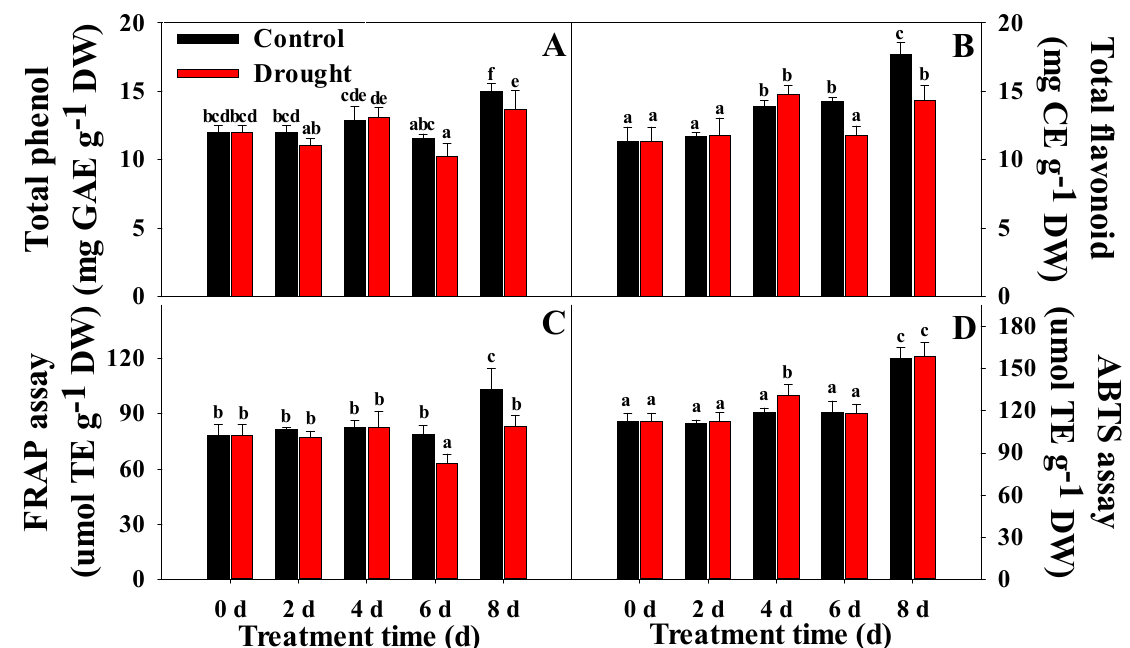
Figure 5. Effect of drought stress on total phenol content ( A ), total flavonoid content ( B ), FRAP assay ( C ), and ABTS assay ( D ) in lettuce seedlings during progressive treatment time. Vertical bars represent mean ± SD of three replicates, and different letters indicate statistically significant differences by Duncan’s multiple range test at p < 0.05. FRAP: ferric-reducing antioxidant power, ABTS: 2,2 ′ -azino-bis(3-ethylbenzothiazoline-6-sulfonic acid).